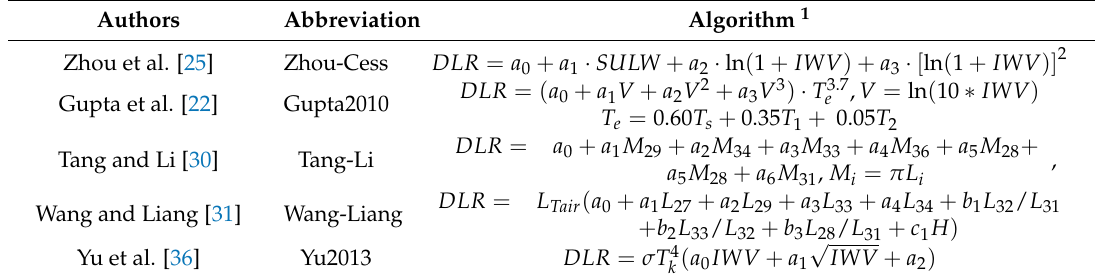
Table 1. Clear-sky downward longwave radiation (DLR)